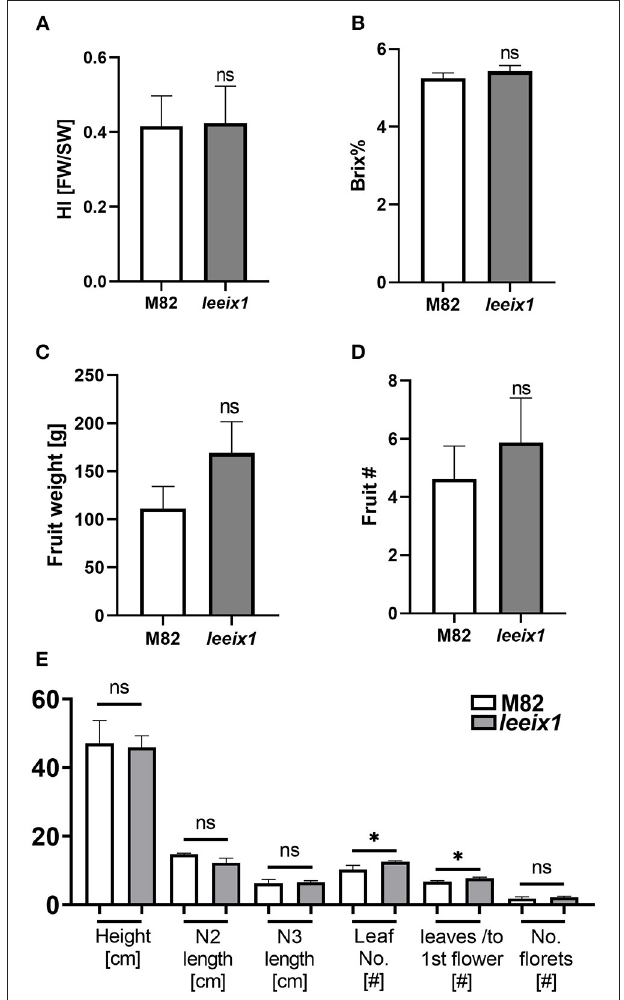
FIGURE 2 | leeix1 mutants have similar agricultural quality as the background M82 line. Agricultural and developmental parameters were measured in M82 and leeix1 plants. Both mutant lines, #b5 and #14, were used in the experiments. (A) Harvest index (HI) of plants was calculated as the ratio between the total mass of fruit yield and the total biomass. (B) Total soluble sugars were measured using a refractometer and are expressed as ◦ Brix. (C) Total fruit weight per plant. (D) The average total number of tomato fruits produced per plant. (E) Analysis of growth and development parameters: Height, length of nodes 2 and 3, Number of leaves, Number of leaves produced in the vegetative stage (before the first flower), and Number of florets. Average ± SEM of at least four independent replicates is shown, N = 18. Except in the number of leaves, no statistically significant differences were observed among WT and leeix1 ( t -test, Welch’s correction). * p <